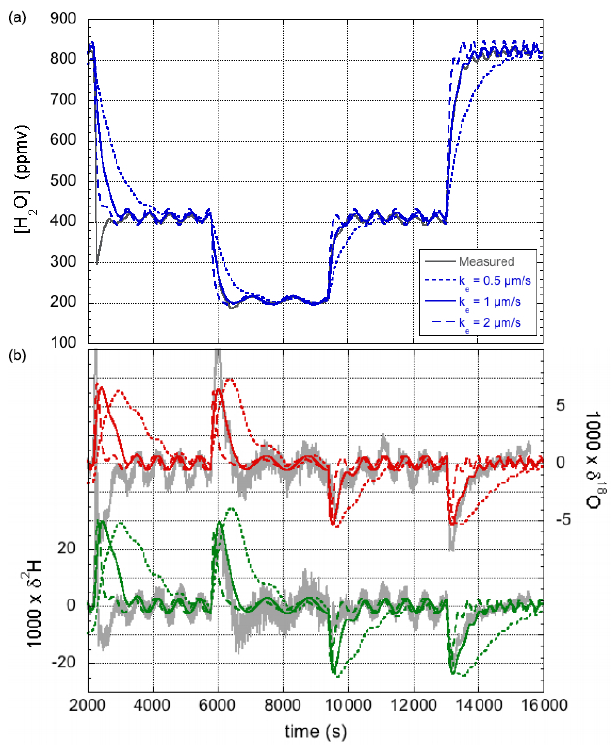
Figure 5. Humidity (a) and isotope responses (b) of the modified LHLG subject to stepwise changes in the water flow rate. The best fit (blue for the humidity response, green for δ 2 H, and red for δ 18 O) to the experimental data (gray curves) is obtained for an evaporation rate of k e = 1µms − 1 . The overshoot in the first measured down- ward humidity transition and the corresponding inverted isotope re- sponse are most likely due to an air bubble in the water